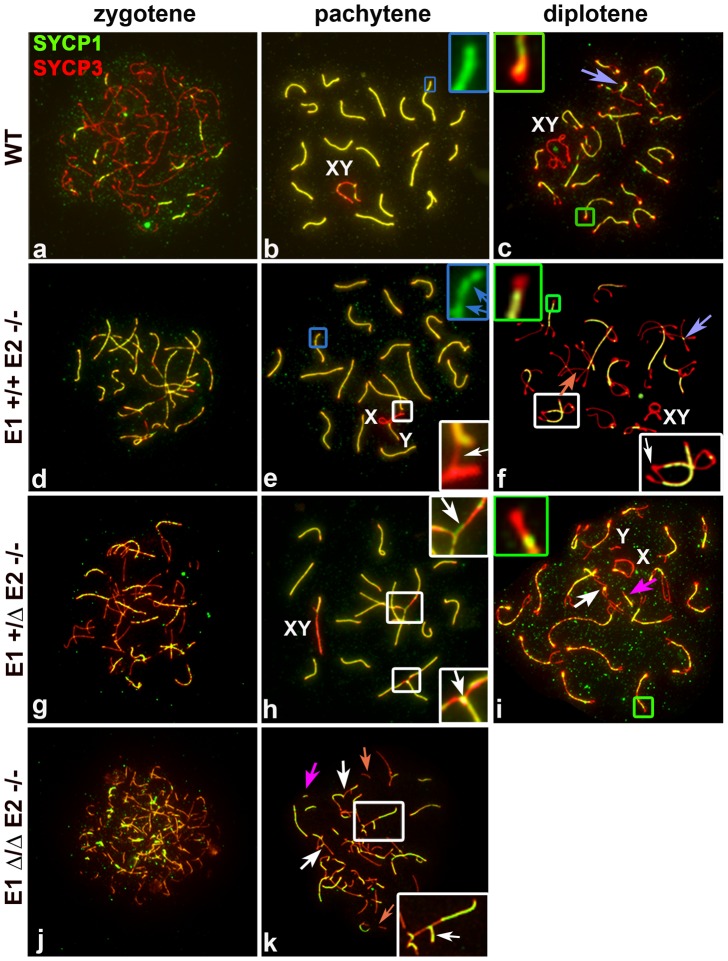
E2 deficiency disrupts normal pairing and synapsis that is exacerbated by loss of E1.Chromosome spreads from adult WT (a–c), E1+/+E2−/− (d–f) E1+/ΔE2−/− (g–i) and E1Δ/ΔE2−/− spermatocytes (j,k) immunostained with SYCP1 (green) and SYCP3 (red). Insets are a magnification of the outlined area. Schematic interpretations of the chromosomal associations shown in the insets are presented in Figure S5. (a–c) Normal progression of synapsis in WT spermatocytes. (b) Uniform SYCP1 pattern in the SC during pachytene (blue inset). (c) Chromosomes remain partially attached by chiasma (purple arrow) and SCAS are evident (green inset). (d–k) Irregular SYCP1 loading in E1+/+E2−/−, E1+/ΔE2−/− and E1Δ/ΔE2−/− spermatocytes at pachytene (e,blue inset, blue arrows; h,k) and diplotene (f,i); non-homologous chromosome associations (white insets) involving the XY chromosomes (XY) and formation of SC (white arrows). (i,k) Note the presence of short fragments of AE (light orange arrow) and SC (dark pink arrows). (i) Thinner SCAS than in WT chromosomes are visible at diplotene (green inset).